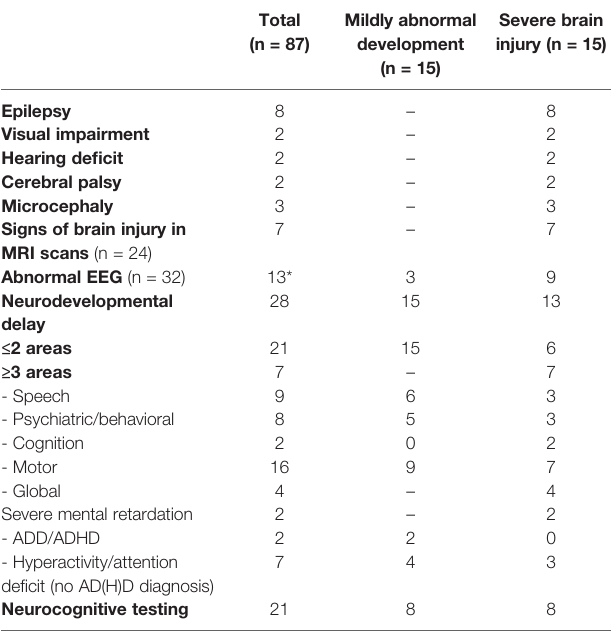
Data arepresented as number. *Including onechild without abnormal neurodevelopment. MRI, magnetic resonance imaging; EEG, electroencephalography; (AD(H)D), attention de fi cit (hyperactivity)